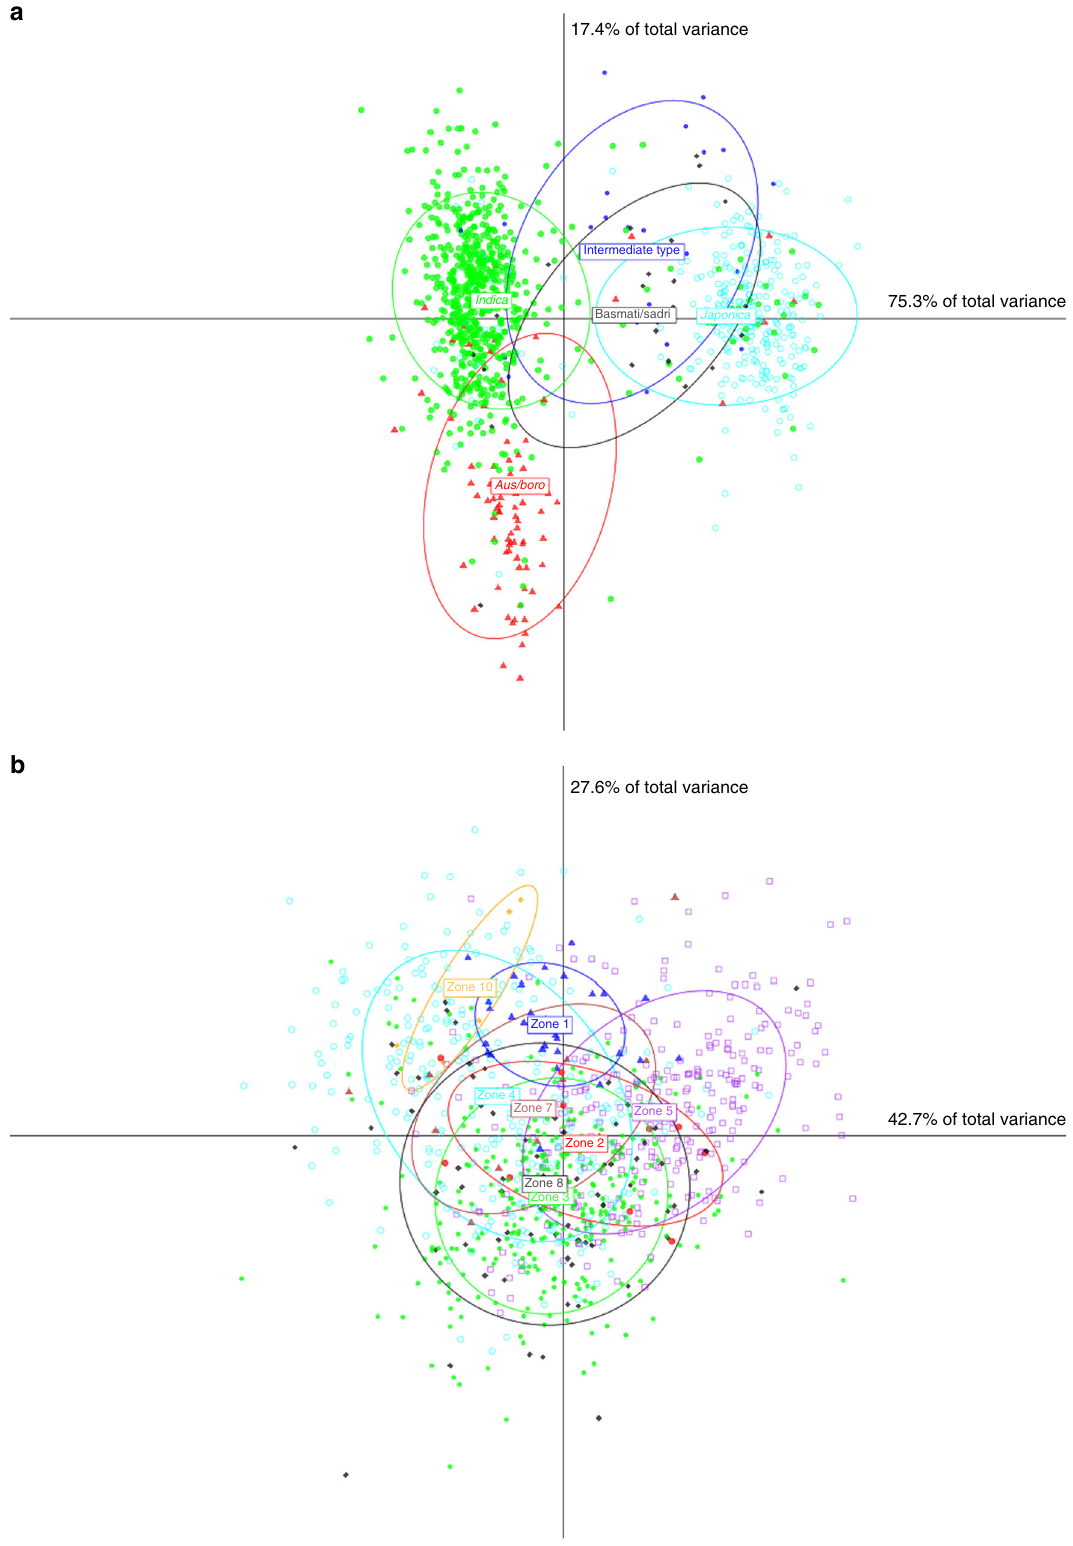
Fig. 5 Discriminant analysis of the 3000 genomes using TIPs. Discriminant analysis of principal components was performed using TE insertions for all the 32 TE families as a function of varietal groups in green for the Indica varieties and in blue for the Japonica varieties ( a ) or in function of geographical zones ( b ). Zone 1 (blue): Japan and Korea; zone 2 (red): China; zone 3 (green): South-East Asia — Thailand, Laos, Malaysia, Cambodia, and Myanmar; zone 4 (cyan): Asian peninsula — Taiwan, Indonesia, Philipines, and Australia; zone 5 (purple): Pakistan, India, Bangladesh, Nepal, Egypt, and Sri Lanka; zone 6: Europe; zone 7 (brown): Madagascar; zone 8 (black): Africa; zone 9: North America; and zone 10 (orange): South